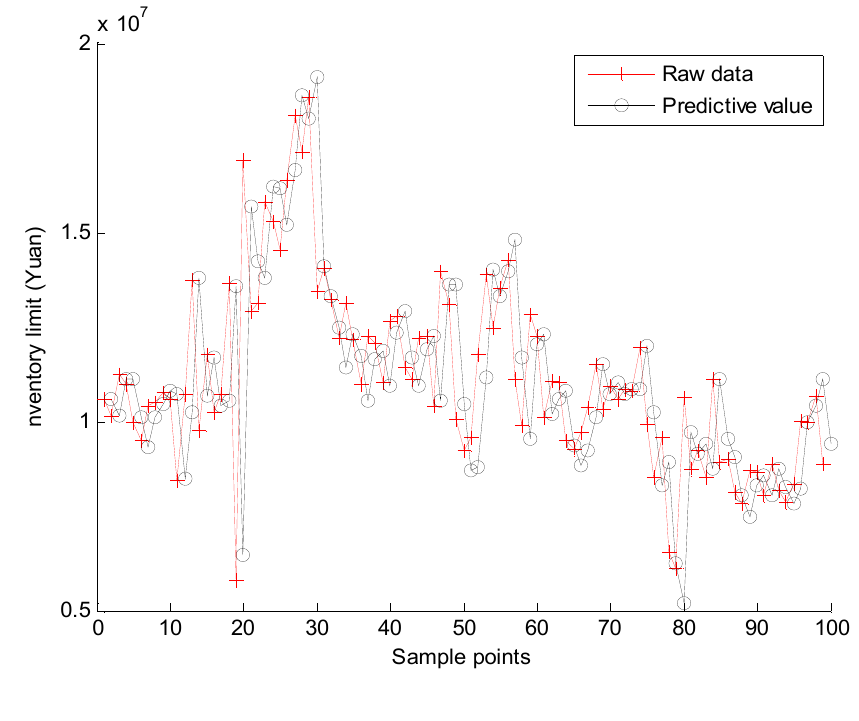
Figure 9. Predictive results of the second exponential smoothing method in